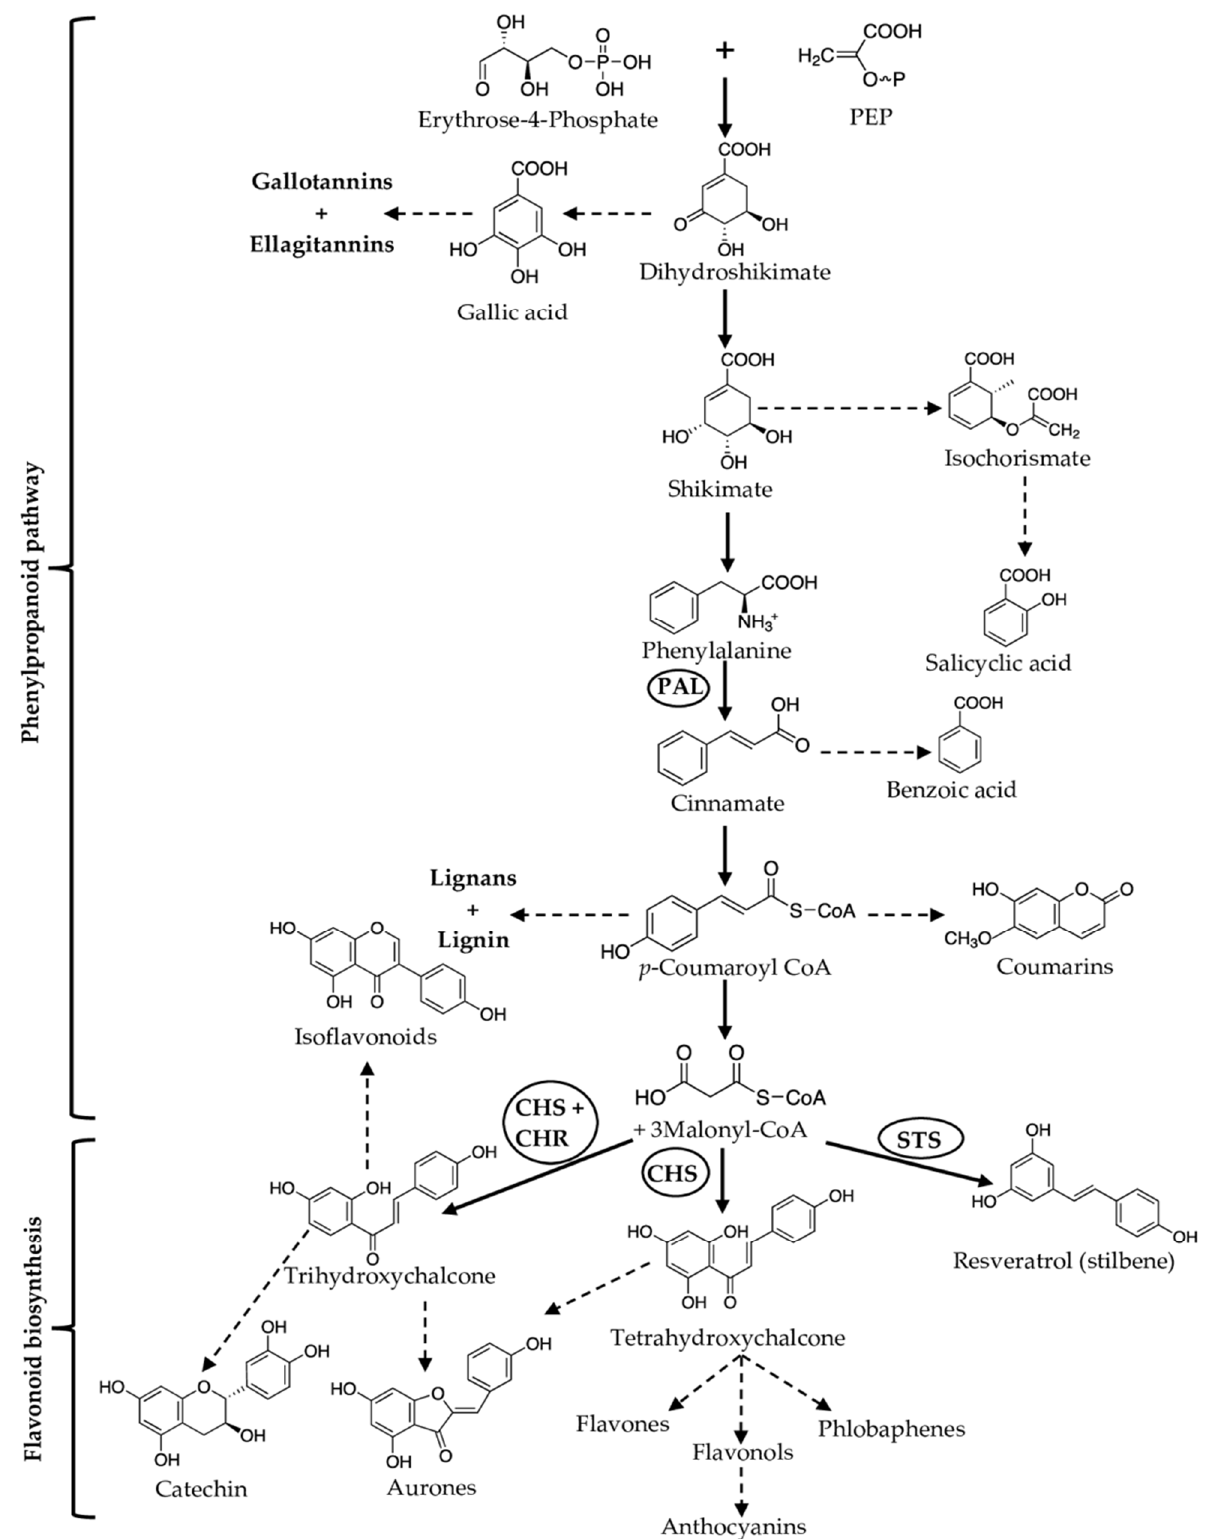
Figure 6. General phenylpropanoid pathway and flavonoid biosynthesis (adapted from [247,248]. Solid arrows represent single enzymatic reaction; dashed arrows represent multiple sequential reactions. Enzymes involved: PAL—phenylalanine ammonia lyase; CHS—chalcone synthase; STS— stilbene synthase; CHR—chalcone reductase.